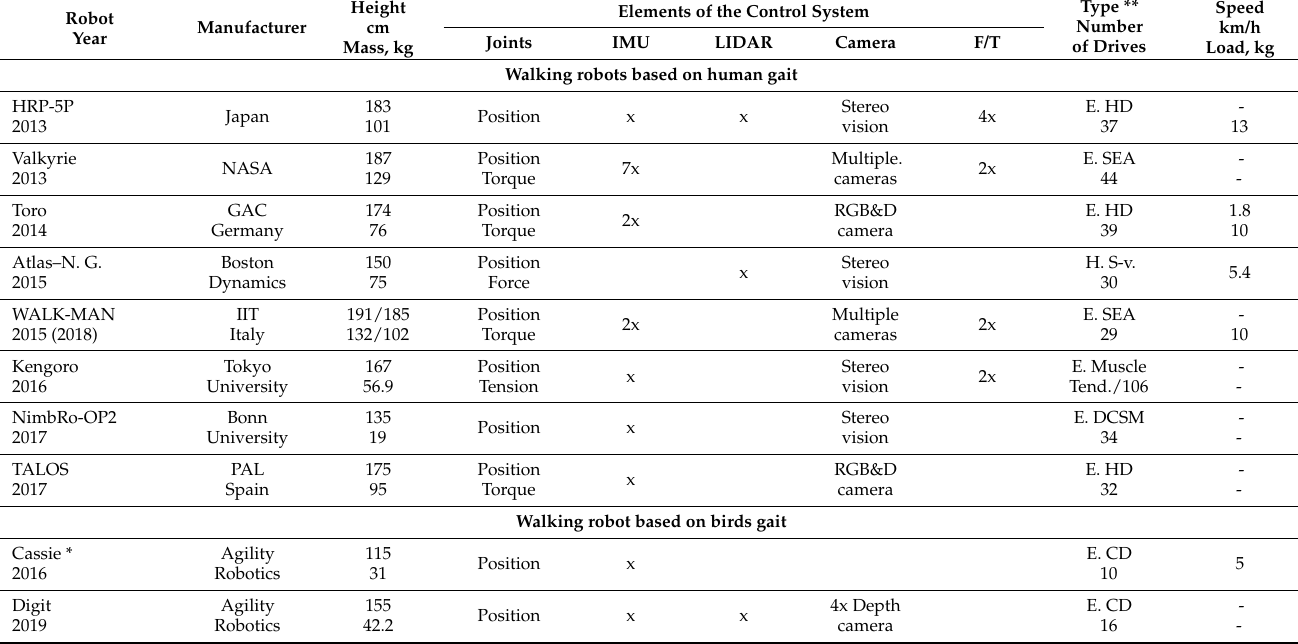
Table 2. Comparison of known modern bipedal robots based on human or bird’s